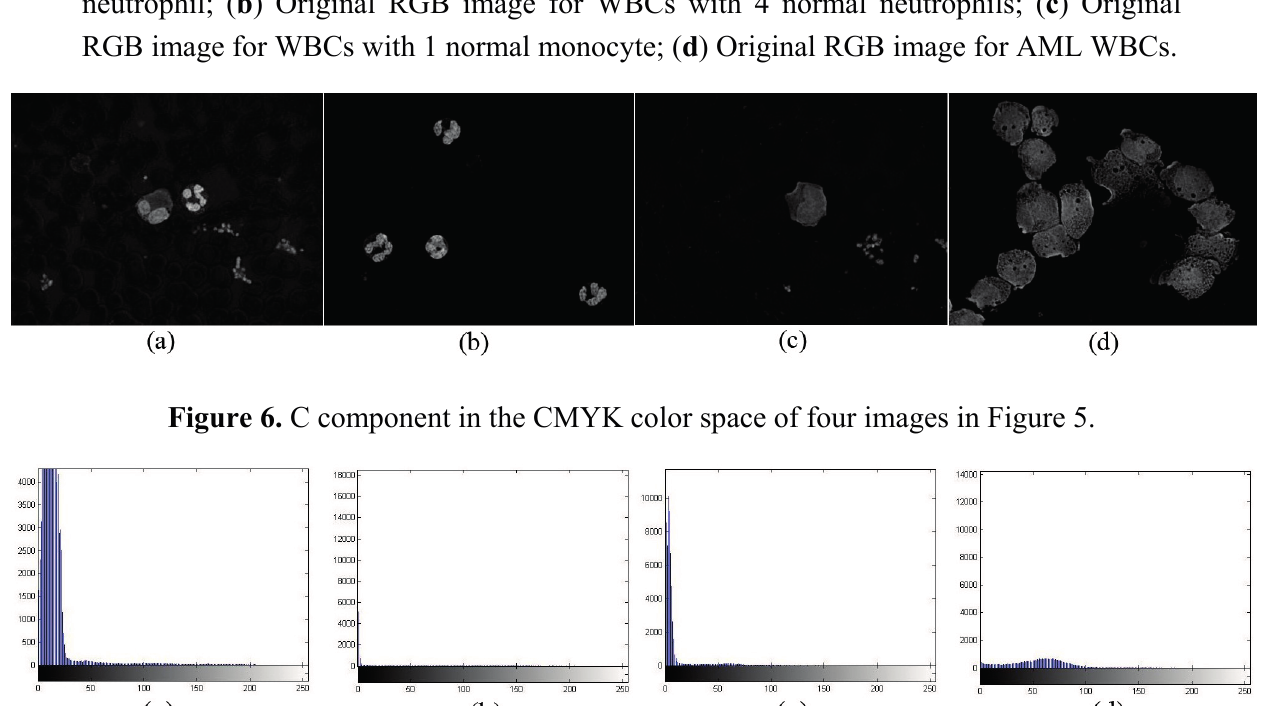
Figure 5. ( a ) Original RGB image for WBCs with 1 normal eosinophil, 1 normal staff neutrophil; ( b ) Original RGB image for WBCs with 4 normal neutrophils; ( c ) Original